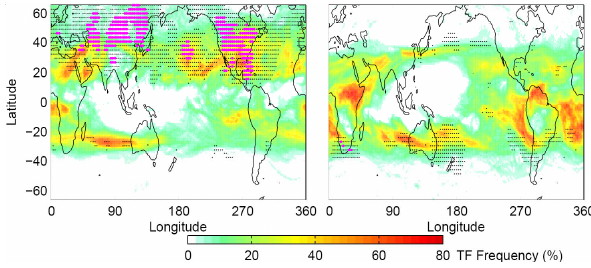
Fig. 7. TF frequency (colour, unit: %) for June (left) and December (right) 2005 with STE O 3 fluxes (unit: gm − 2 yr − 1 ) shown by black dots (2 ≤ STE < 4) and magenta dots (STE ≥ 4). The TF frequency is calculated by dividing the number of times that a TF occurs (i.e., sampled every 2h) by the total times